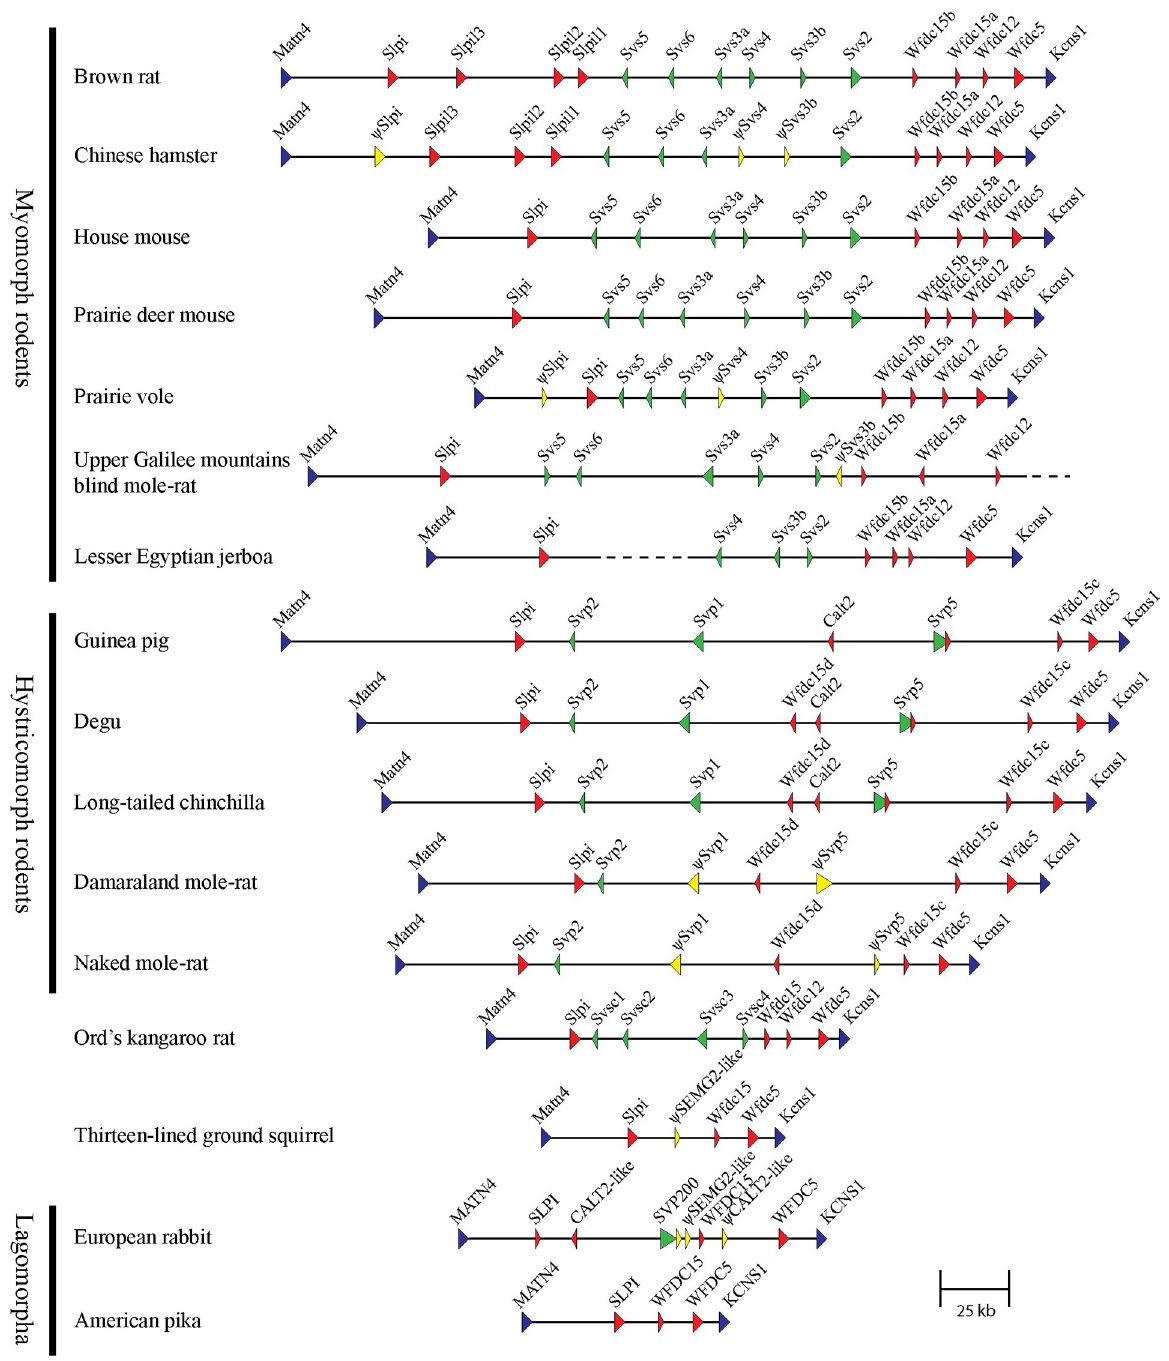
Fig 8. Outline of the REST gene loci in Glires. The loci are illustrated as horizontal lines, with arrowheads showing the approximate location and orientation of genes. The colors depict the genes as follows: blue for locus flanking genes, red for WFDC genes, green for REST genes, yellow for pseudogenes, and grey for genes with uncertain status ( i . e . they might be truncated functional genes or pseudogenes). Genes encoding one or two WFDC domains are indicated by small and large arrowheads respectively. The arrowheads depicting REST genes are small, medium, or large in order to reflect the relative size of their